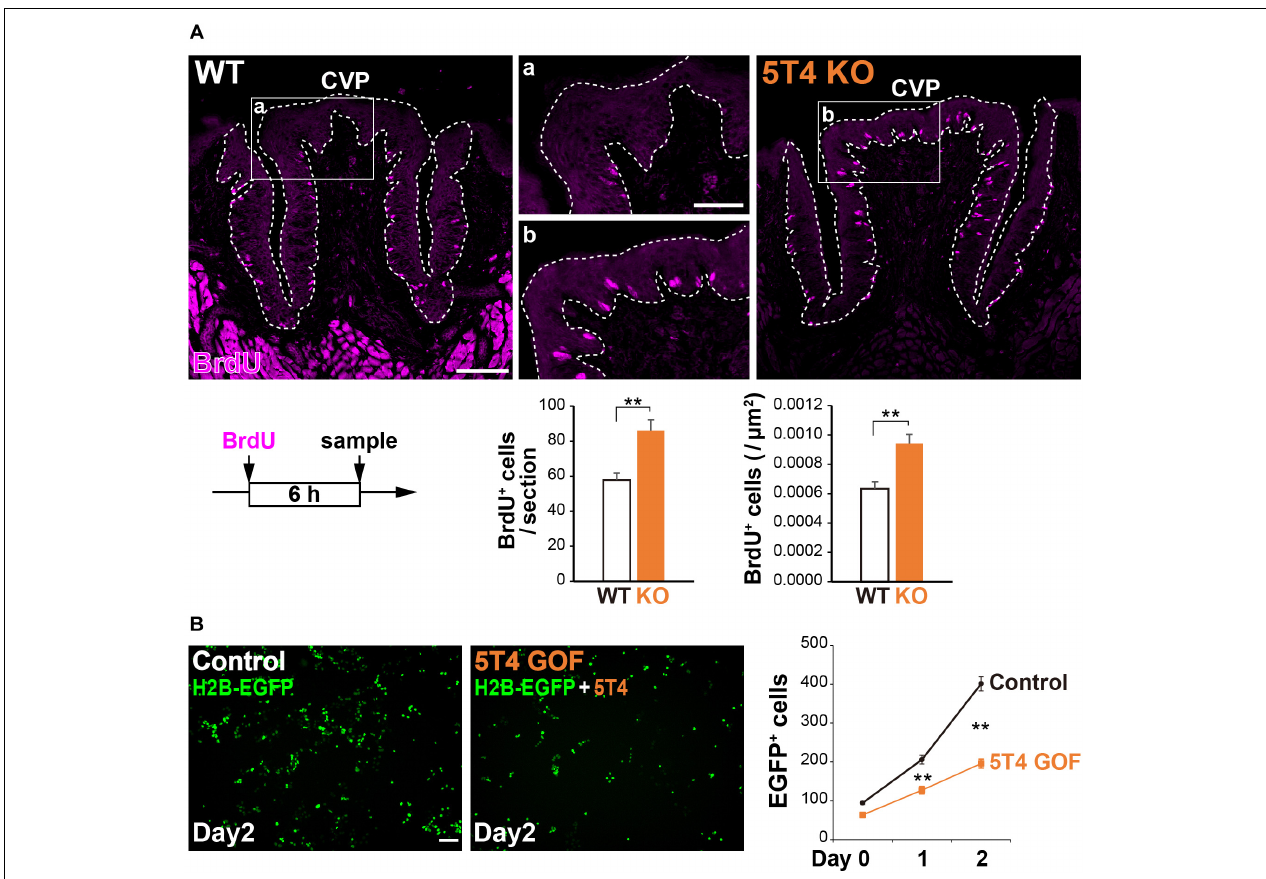
FIGURE 5 | Loss of 5T4 function significantly increases the number of proliferating cells in the CVP. ( A , Top) Cell proliferation in the WT and 5T4 -KO CVPs. WT and 5T4 -KO mice were intraperitoneally injected with BrdU. Six hours after BrdU injection, cells in the CVP were immunostained with an anti-BrdU antibody (magenta). Scale bars, 100 µ m. Images are Z-stack projections of seven sections (0.56 µ m/slice). (Bottom) Numbers of BrdU + cells are expressed as the mean ± SEM ( ∗∗ p < 0.01, Student’s t test; n = 16 sections from six WT mice, n = 8 sections from three 5T4 -KO mice). ( B , Left) GOF experiments for 5T4 in HEK293T cells. HEK293T cells were transfected with p CAG - H2B-EGFP alone (Control) or together with p CAG - 5T4 (5T4 GOF). One day after transfection, cells were passaged (Day 0) and then cultured for 2 days (Day 2). Scale bars, 100 µ m. (Right) Numbers of EGFP + cells at Day 0–2 are expressed as the mean ± SEM ( ∗∗ p < 0.01